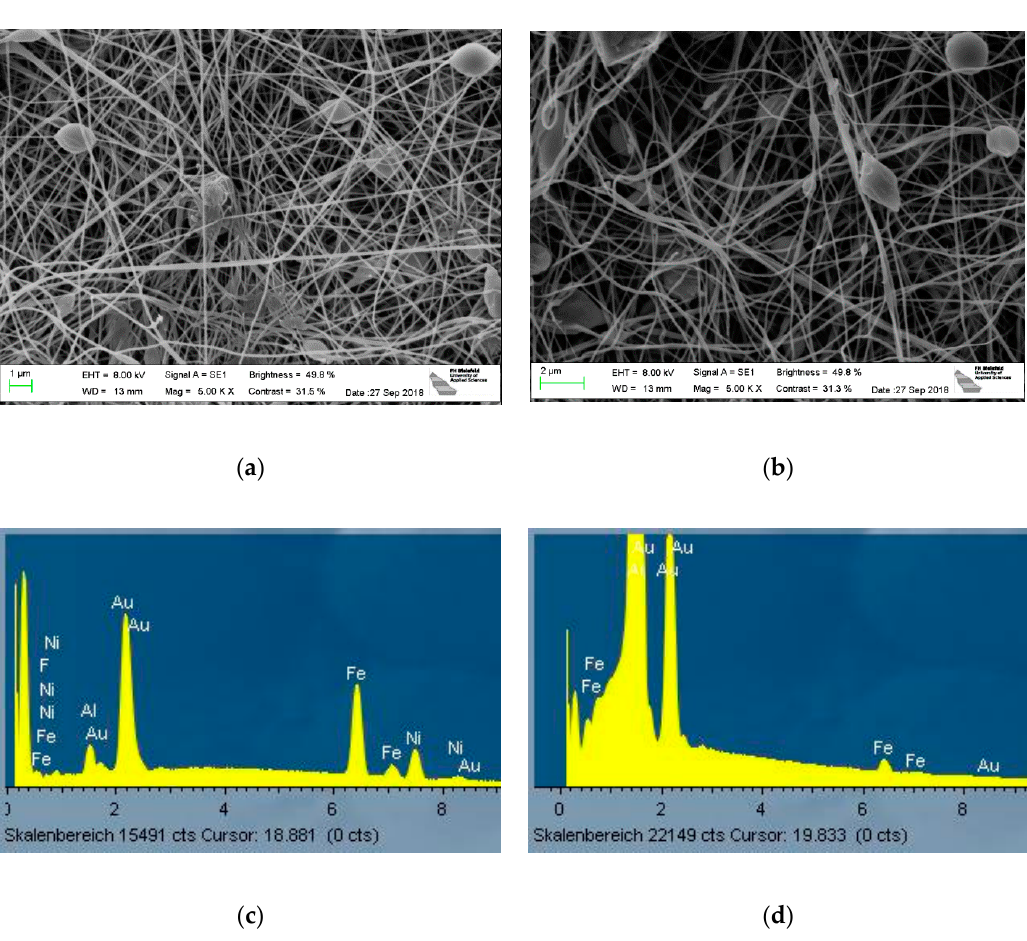
Figure 7. SEM images with a nominal magnification of 5000 x, showing ( a ) a PAN/diiron nickel tetraoxide nanofiber mats with a weight ratio of 1:0.79; ( b ) PAN/magnetite nanofiber mat with a weight ratio of 1:0.79; ( c ) and ( d ) corresponding EDX